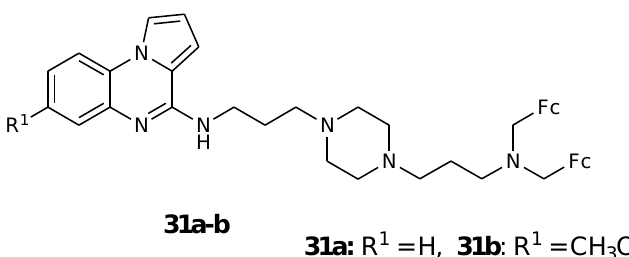
Figure 12. Structure of synthesized ferrocenyl pyrrolo[1,2-a]quinoxaline derivatives ( 30a – b and 31a – b ).